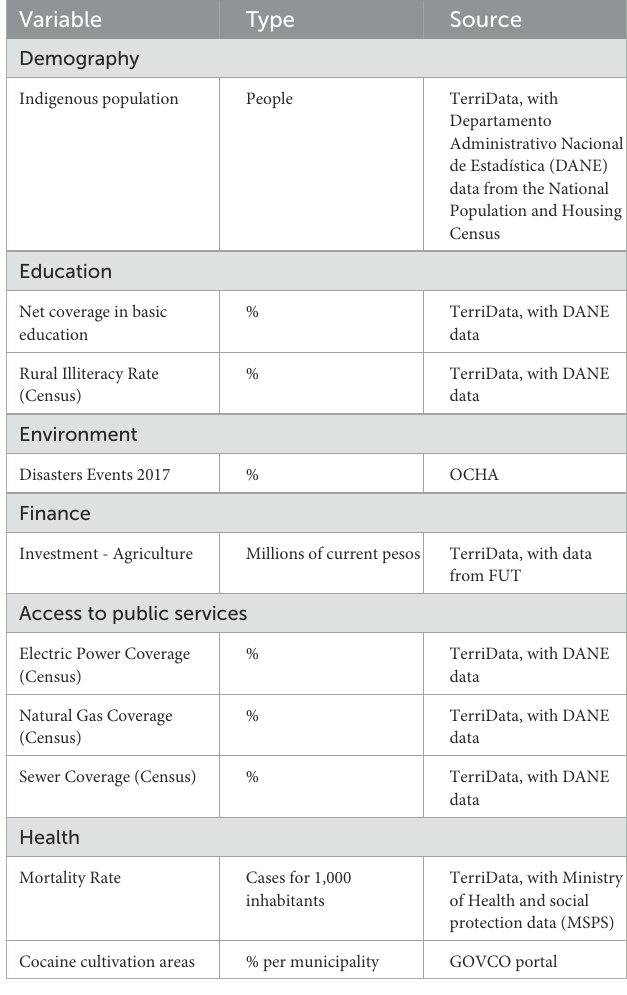
TABLE 1 Explanatory variables considered after feature selection